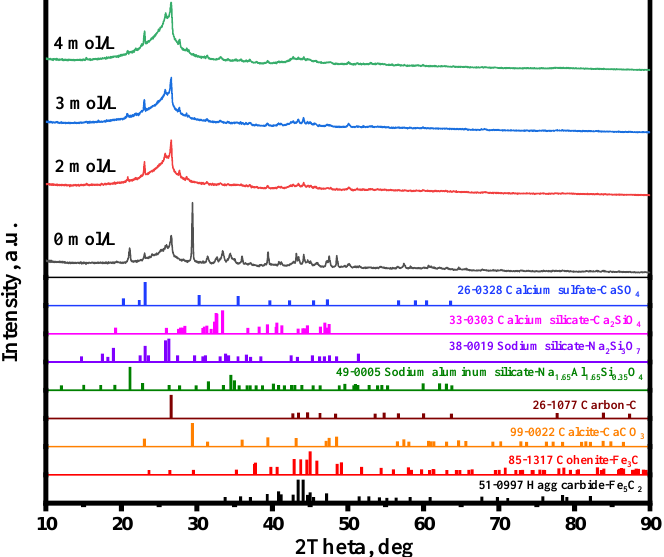
Figure 13. XRD patterns of acid leaching concentrate with different acetic acid concentrations.